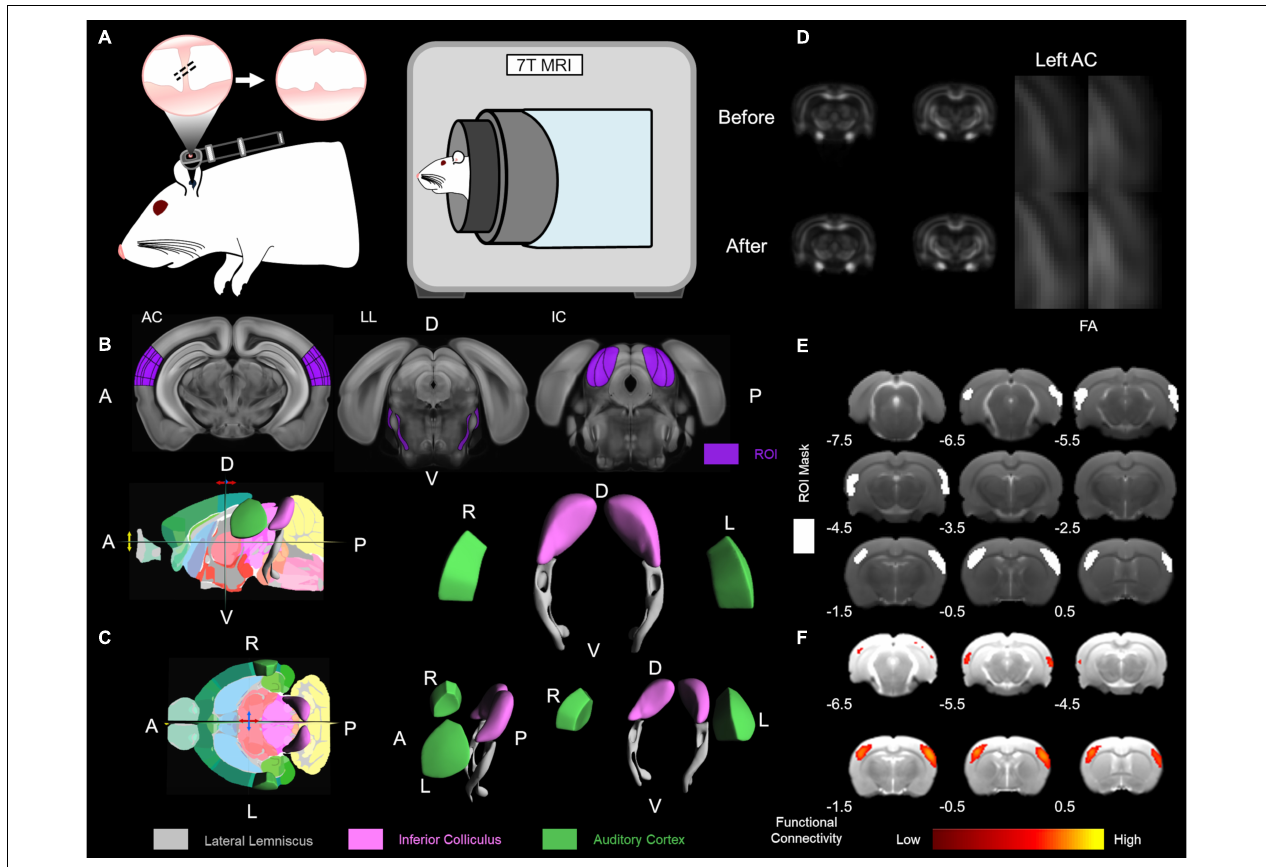
FIGURE 1 | Experimental design and data analysis. (A) The CHL surgery was conducted by tympanic membrane (TM) puncture and malleus displacement. A schematic of the rat ear with the otoscope highlighting the TM is depicted. Hash marks across the malleus indicate displacement and TM puncture with the serrated TM on the right. To the immediate right, the 7 Tesla magnetic resonance imaging (MRI) scanner for rodent structure-functional MRI (PharmaScan, Bruker Biospin). The Allen Mouse Brain Reference Atlas was used for visualization (Lein et al., 2007). (B) The Allen Mouse Brain Reference Atlas average template (Lein et al., 2007) with the region of interest (ROI), in dark purple, from left to right: AC 80 image, LL 96 image, and IC 101 image. (C) The Allen Mouse Brain Atlas 3D rendering a cutaway of the longitudinal/sagittal plane (top) and horizontal/transverse plane (bottom) with the 2D coronal reference atlas (Lein et al., 2007). The Allen Mouse Brain Atlas 3D volumetric rendering tilted in the horizontal plane rotated left 5 ◦ (top), tilted in the horizontal plane rotated left 20 ◦ (bottom), and tilted in the horizontal plane rotated left 90 ◦ (bottom left), all in the y-axis translation. Volumetric ROI are color-coded lateral lemniscus in gray, inferior colliculus (IC) in light purple (lavender) and auditory cortex in green. R – right, L – left, D – dorsal, V – ventral, A – anterior, P – posterior. (D) Diffusion tensor imaging (DTI) fractional anisotropy (FA) of the before and 1 week after CHL timepoints. The left auditory cortex (AC) is highlighted in the zoomed insert. (E) The ROI for masks used for functional connectivity are delineated in white. Bregma coordinates (in mm) are below the brain. (F) Functional connectivity maps using a color bar depicted from the correlation coefficient and